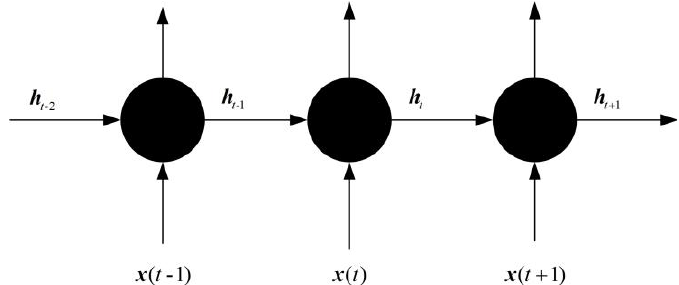
Figure 3. Traditional RNN structure diagram.